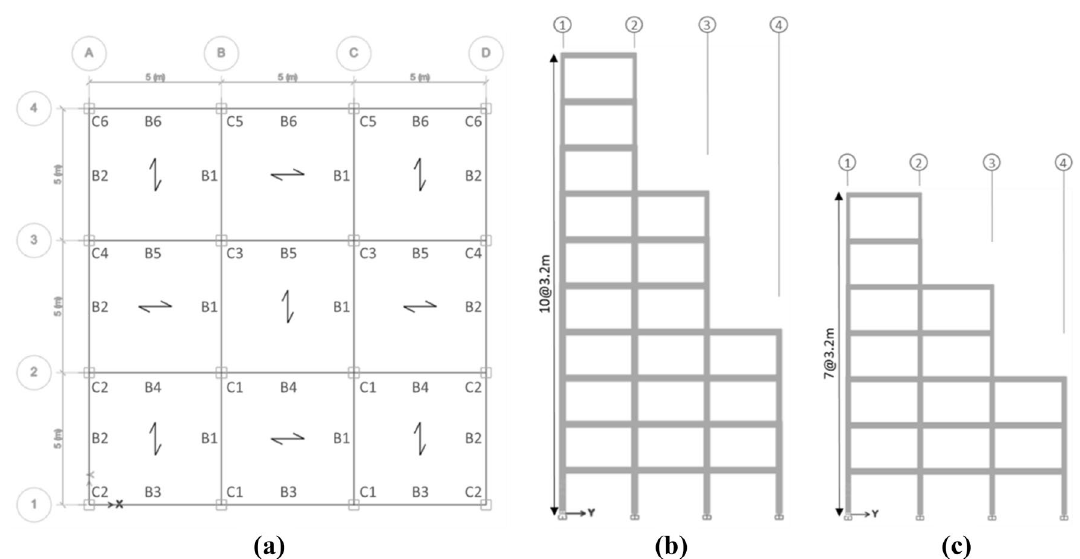
Figure 5. ( a ) The structural plan and sections of the setback irregular ( b ) 10 and ( c ) 7-story